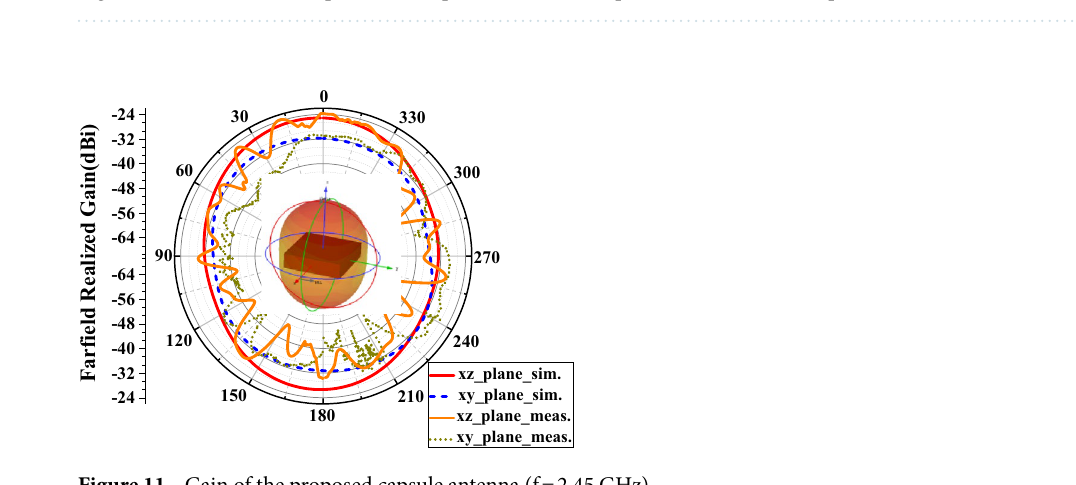
Figure 11. Gain of the proposed capsule antenna (f = 2.45 GHz).